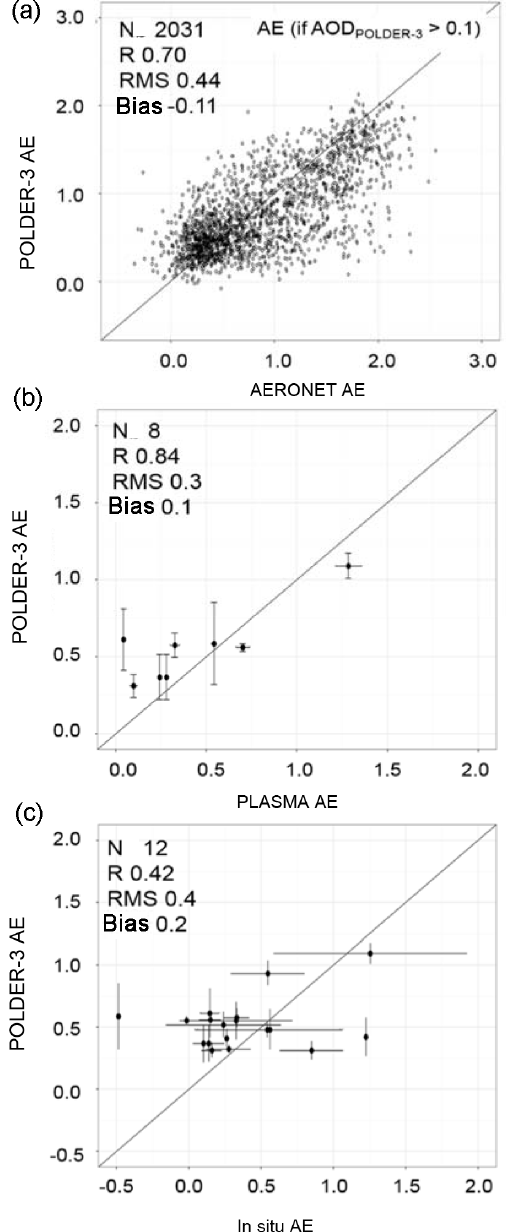
Figure 7. Scatter plots of the Ångström exponent (AE) retrieved by POLDER-3 between 865 and 670nm with respect to coincident and collocated values from (a) the 17 ground-based AERONET sites between 870 and 675nm; (b) airborne PLASMA sun-photometer operated at 870 and 675nm during ADRIMED; (c) optical calcula- tions at 865 and 670nm from number size distributions measured in situ during TRAQA and ADRIMED. Only AERONET values corresponding to POLDER-3 AOD larger than 0.1 are considered. To facilitate the reading, the standard deviations of the AERONET values are not represented. Characteristics of the linear correlations are also reported (number of points N , correlation coefficient R , RMSE, and bias).